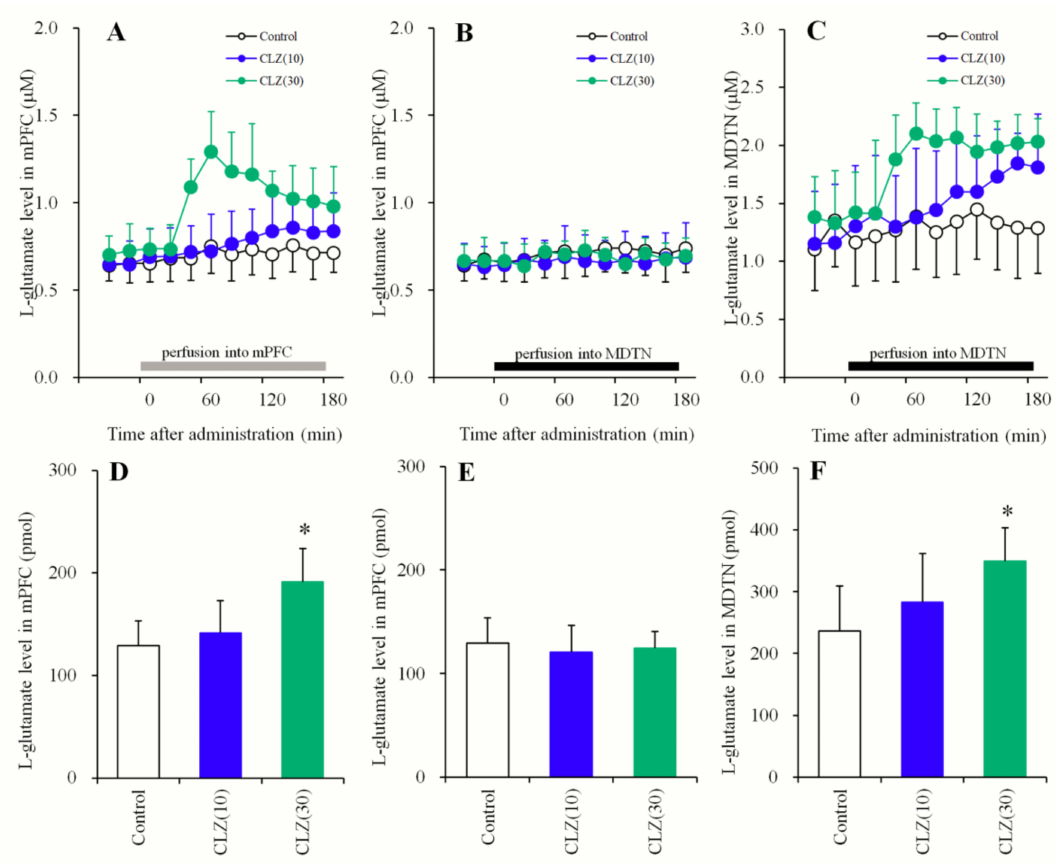
Figure 3. Concentration-dependent e ff ects of the local administration (perfusion) of CLZ into the mPFC ( A , D ) and MDTN ( B , E ) on extracellular l -glutamate levels in the mPFC, and the perfusion into the MDTN on levels in the MDTN ( C , F ). The perfusion medium commenced with MRS. After confirming the stabilization of extracellular l -glutamate levels, the perfusate in the mPFC (A: gray column) or MDTN (BC: black columns) was switched to MRS containing CLZ (10 or 30 µ M) for 180 min. Ordinates: mean ± SD ( n = 6) of extracellular l -glutamate levels ( µ M). Abscissas: time after administration of CLZ perfusion (min). AUC values of l -glutamate levels (pmol) during perfusion with CLZ (from 20 to 180 min) based on ( A – C ) were indicated in ( D – F ), respectively. * p < 0.05. This is relative to the control (opened bar) using LME with Tukey’s post hoc